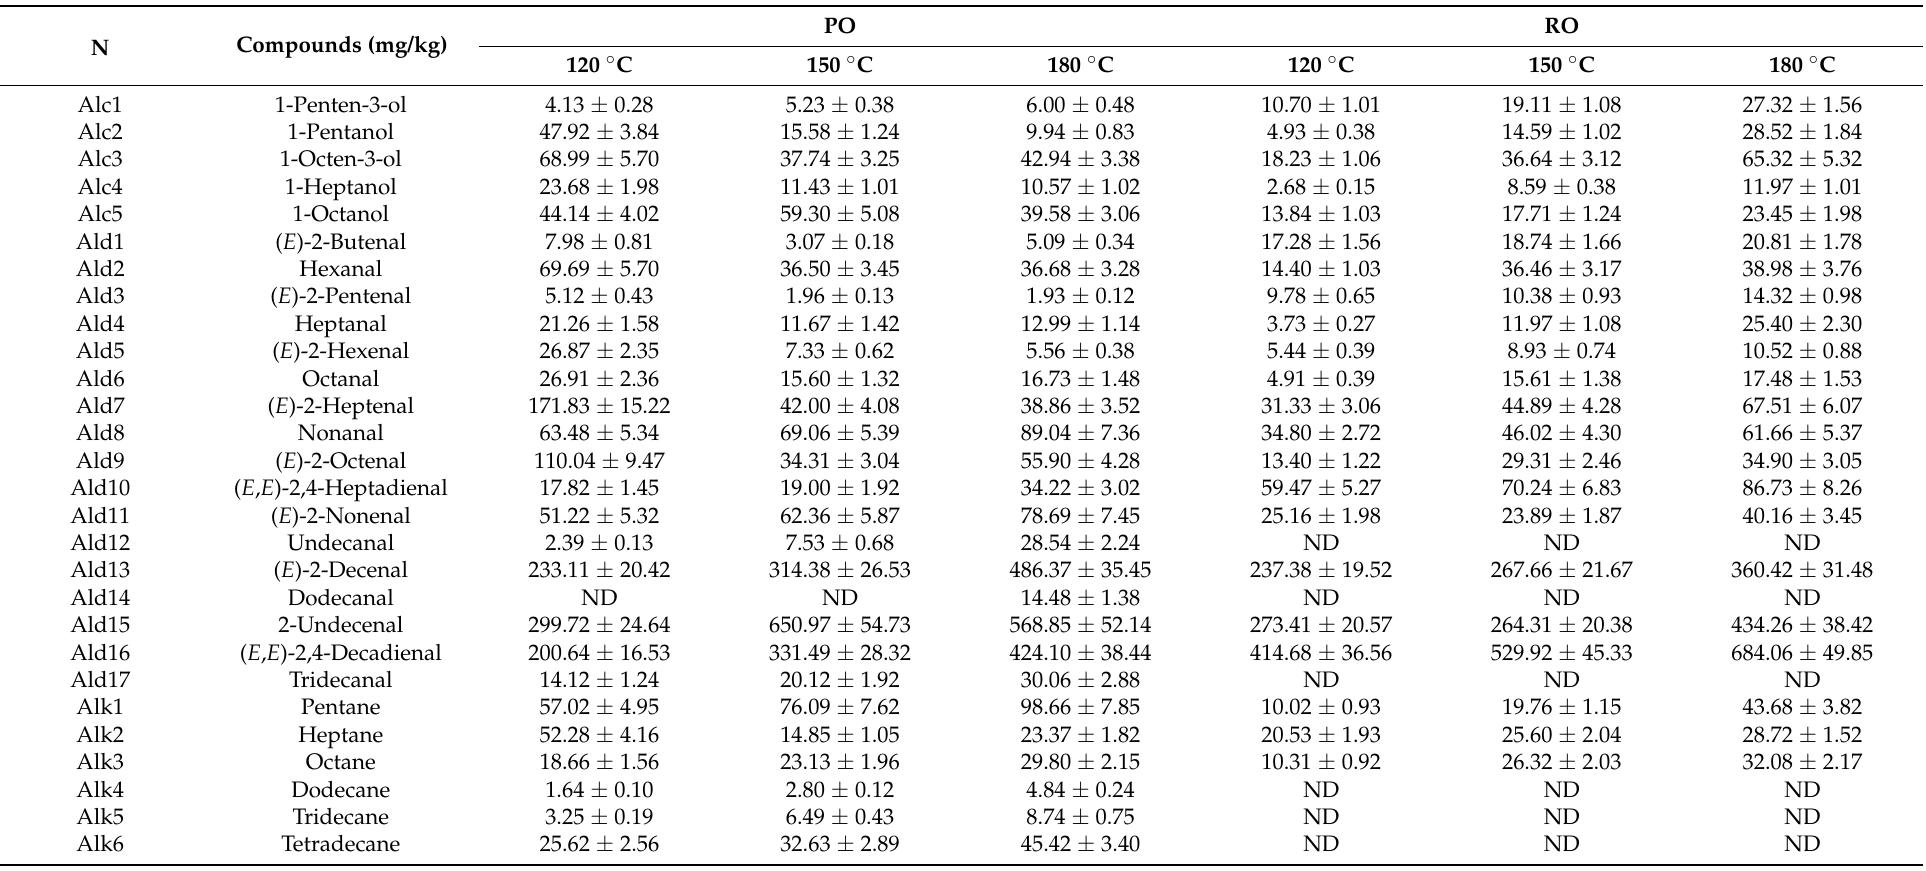
Table 3. Volatile compounds of four vegetable oils heated for 36